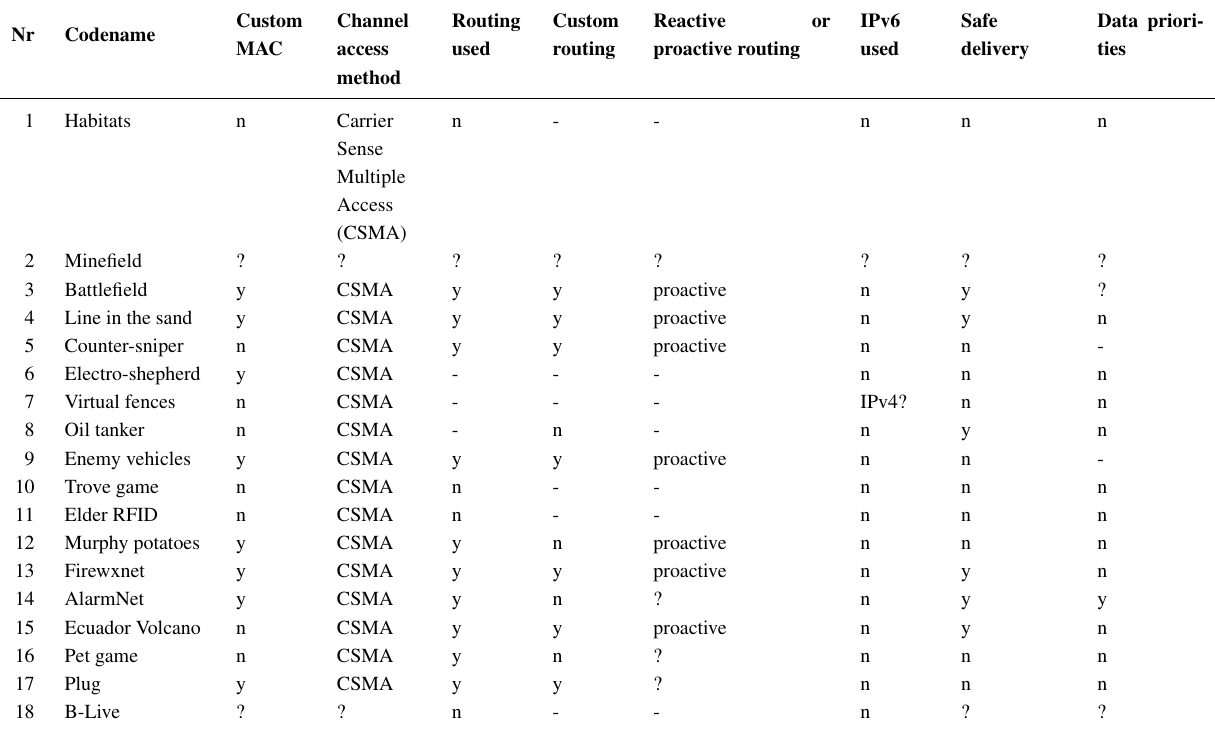
Table 12. Deployments: networking protocol